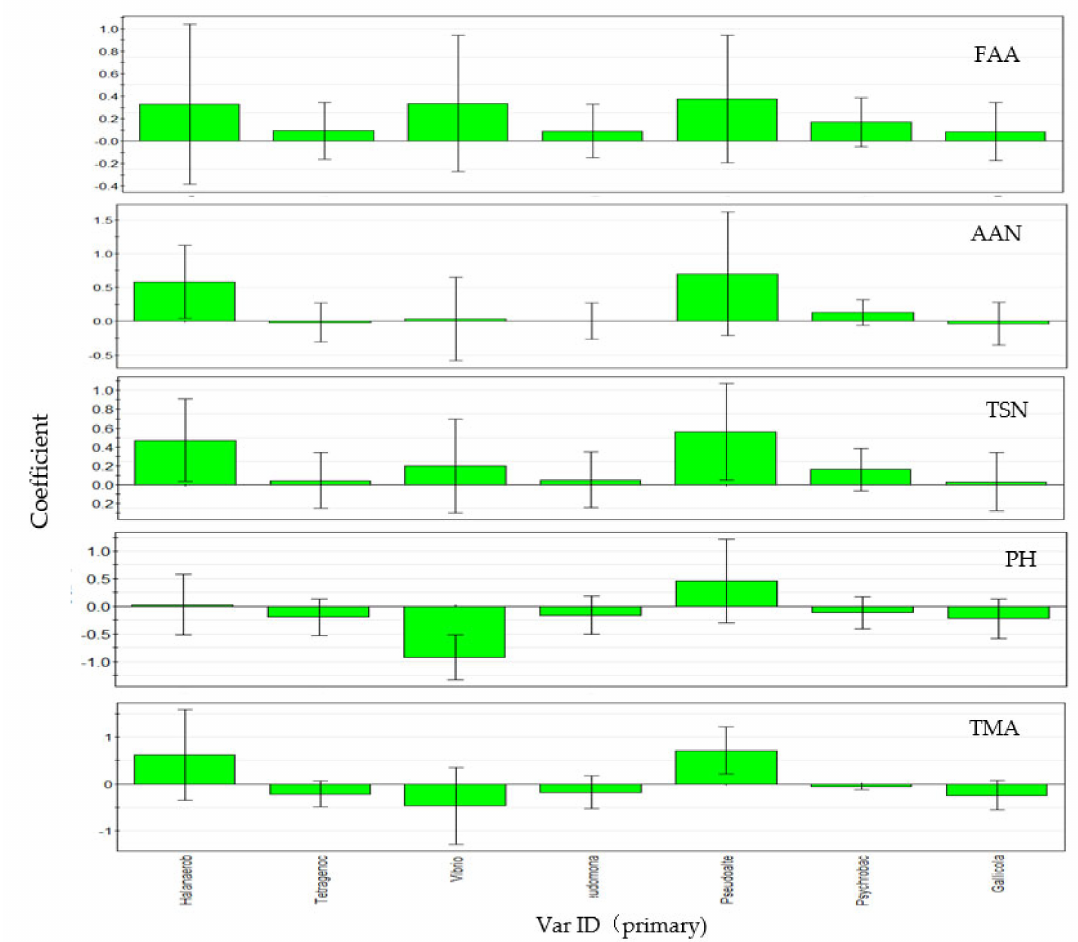
Figure 7. Analysis of the contribution of each index to the quality of fish